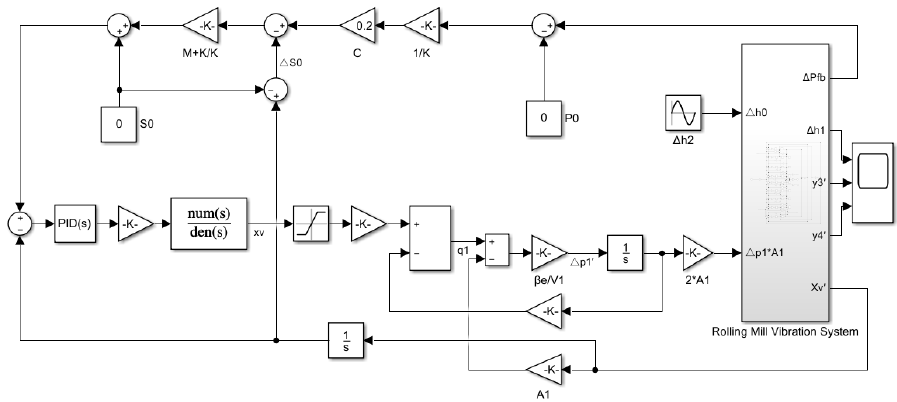
Figure 5. MATLAB/Simulink simulation diagram of mill hydraulic coupling vibration.